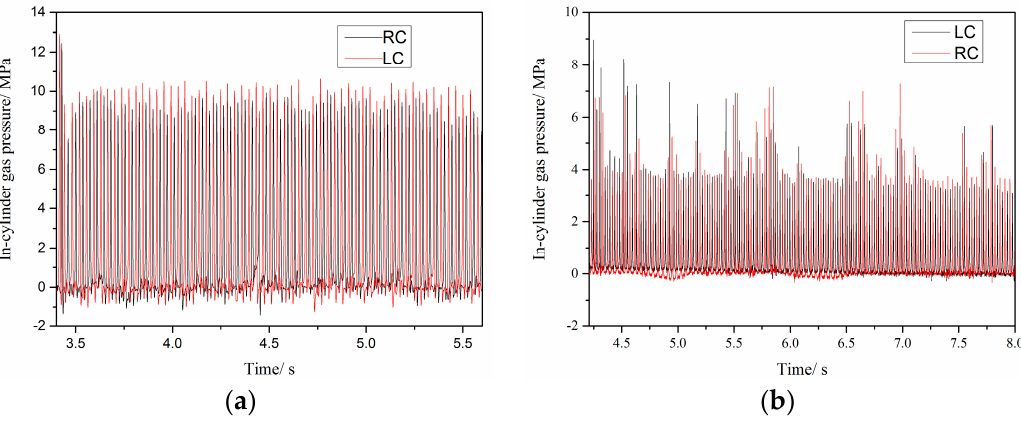
Figure 17. Comparison of the in-cylinder gas pressure for the two injection control strategies. ( a ) velocity signal feedback; ( b ) position feedback.